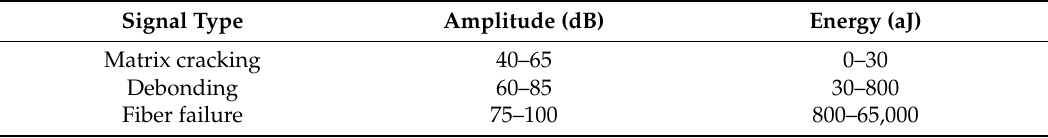
Table 2. Classification of the AE signals based on their amplitude and energy content.